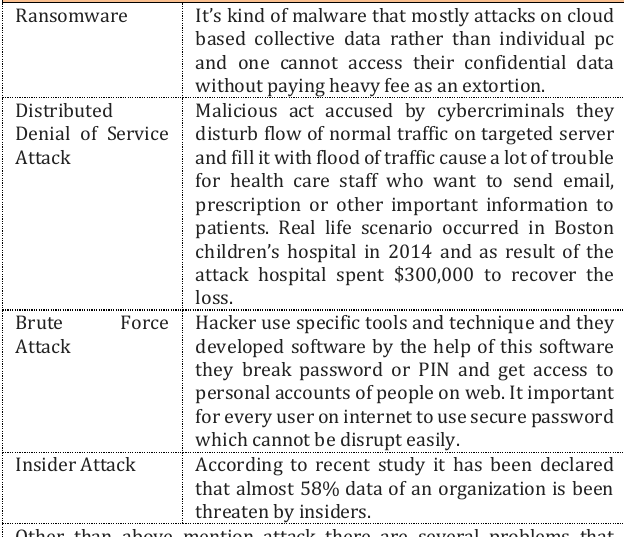
Table 3 : Attack and Challenges on Clod based Data Ransomware